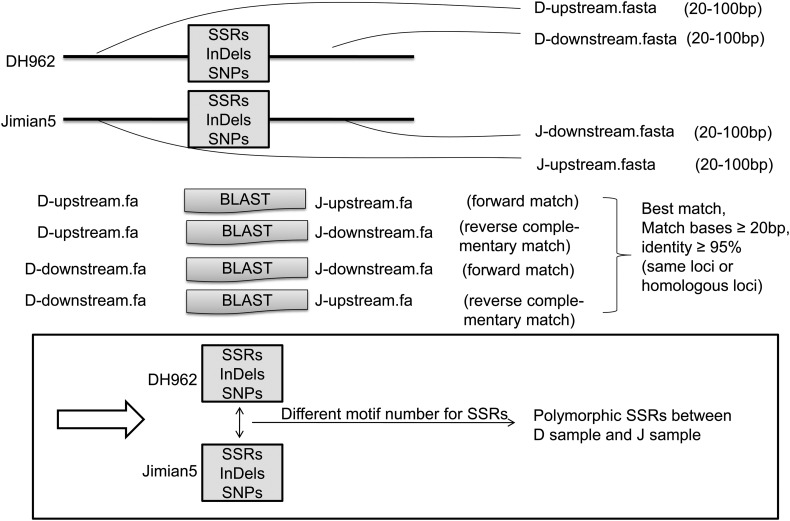
Comparative analysis of the flanking sequences of markers of DH962 and Jimian5.